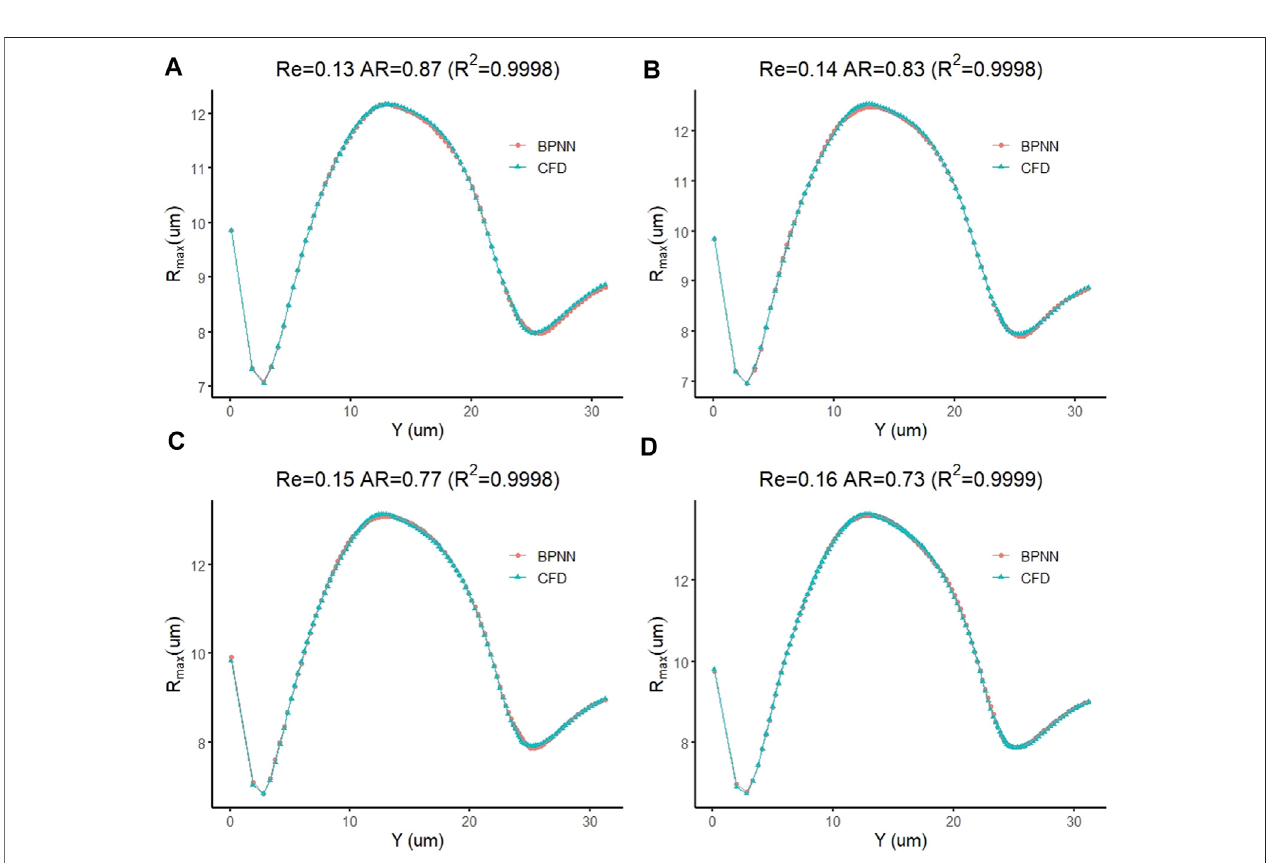
FIGURE 9 | Prediction accuracy test of a leukocyte transmigration prediction model for cell deformation prediction.